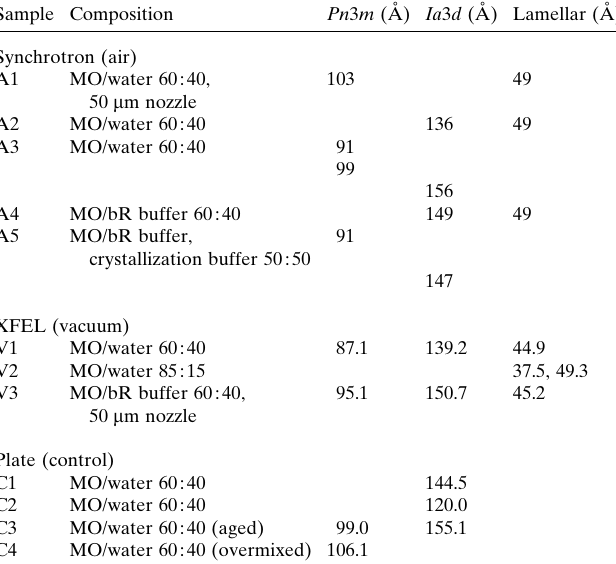
Table 1 Phases and corresponding lattice parameters calculated from X-ray diffraction profiles obtained during HVI of monoolein samples. Samples injected in air at the synchrotron and under vacuum at the XFEL are denoted A and V, respectively. The injector nozzle diameter was 75 m m unless otherwise stated. Control samples, denoted C, were deposited in a 96-well plate for lattice parameter determination without injection. Where multiple phases appear on the same row, the phases were observed concurrently in the diffraction data. Sample